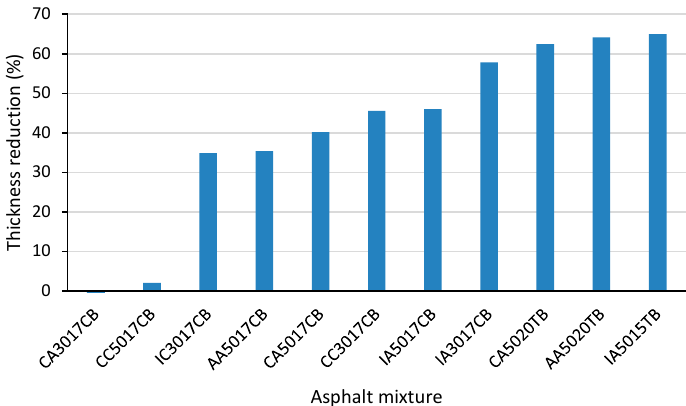
Figure 11. Pavement thickness reduction by using asphalt rubber mixtures.